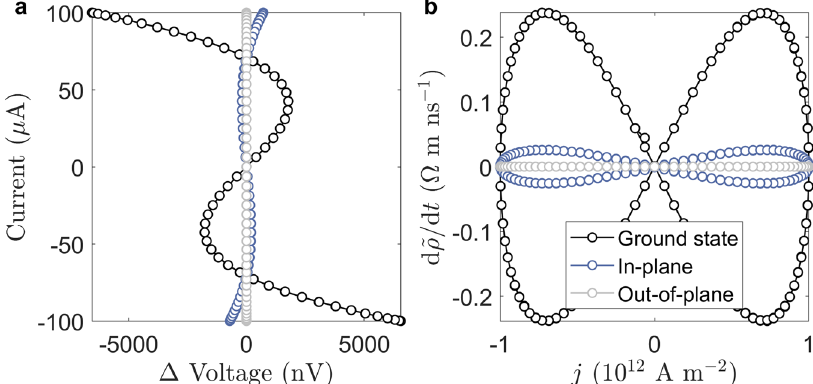
Fig. 3 Hysteresis curves. Change in the resistivity ρ of the ground state (black curve), the in-plane magnetization state (blue) and the out-of-plane magnetic state (light gray). a We plot the current – voltage ( I – Δ V ) diagram of the resistive device as a function of the magnetization. We can see that for currents up to a 100 μ A the resistive states do not possess a noticeable hysteresis in the nanovolts. Yet, the anisotropic magnetoresistance (AMR) leads to a nonlinear resistance state. b We plot the change in resistivity as a function of the current density j , which is in units of 10 11 A m − 2 . From this plot, we can see that the ground state and the in-plane do in fact have a memristance effect, which is however very small. For the out-of-plane state instead, the memristance is zero, as predicted by our model.